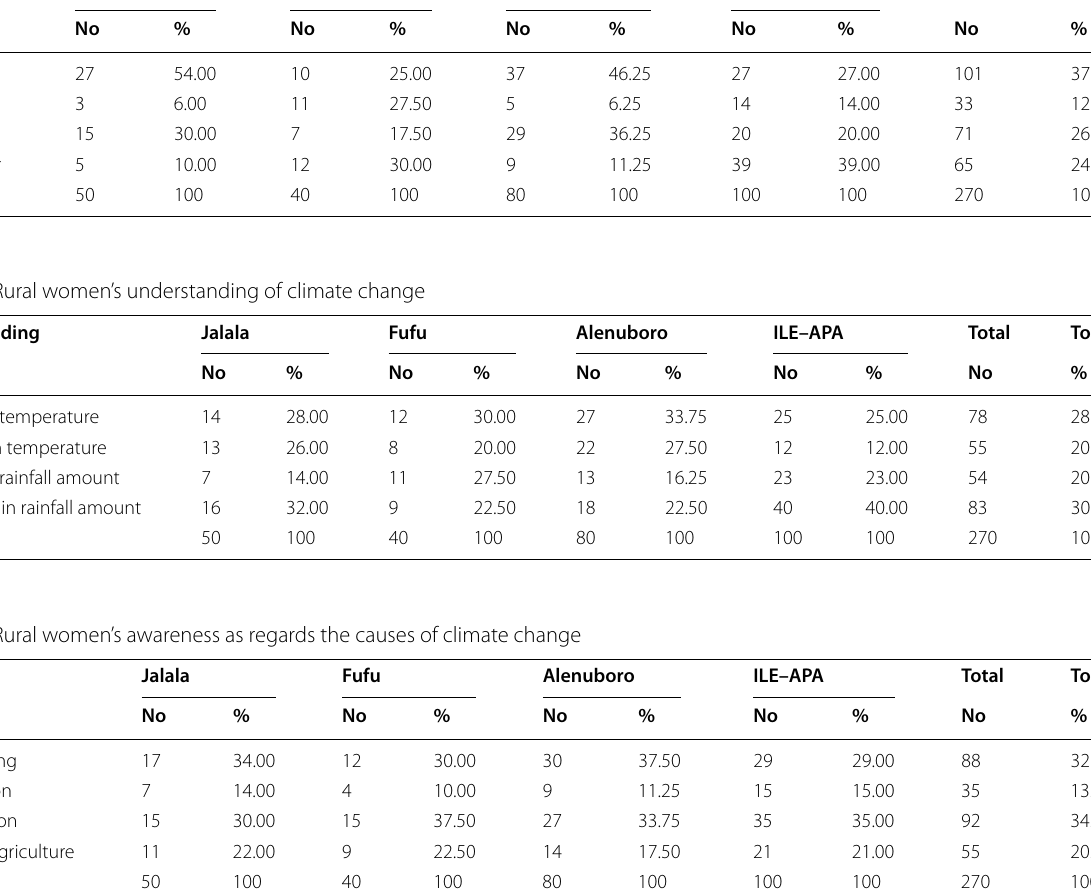
Table 2 Rural women’s source of information on climate change Source